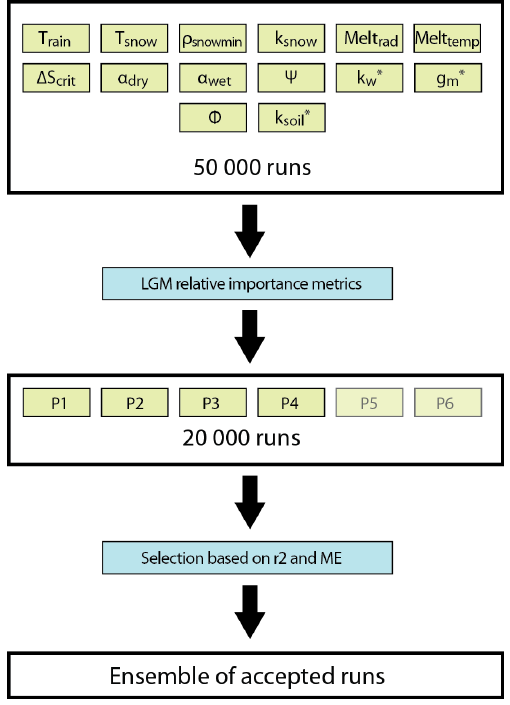
Figure 4. Calibration procedure using the GLUE method in the fol- lowing steps: (a) first iteration, stochastically testing 14 different parameters in 50000 runs, (b) selection of the most sensitive pa- rameters for each site using the LGM method, (c) refinement of the calibration with a second iteration of 20000 runs focusing on the four to six sensitive parameters (may be different for each site), (d) selection of acceptable model set-ups among the 20000 simula- tions based on statistical performance indicators ( r 2 and the mean error, ME) for ground temperature at several depths. Among those four to six set-ups, the median (regarding the evolution of active layer thickness) is eventually used for long-term